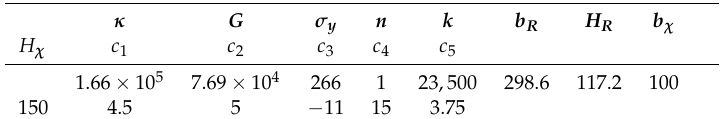
Table 2. The model parameters.